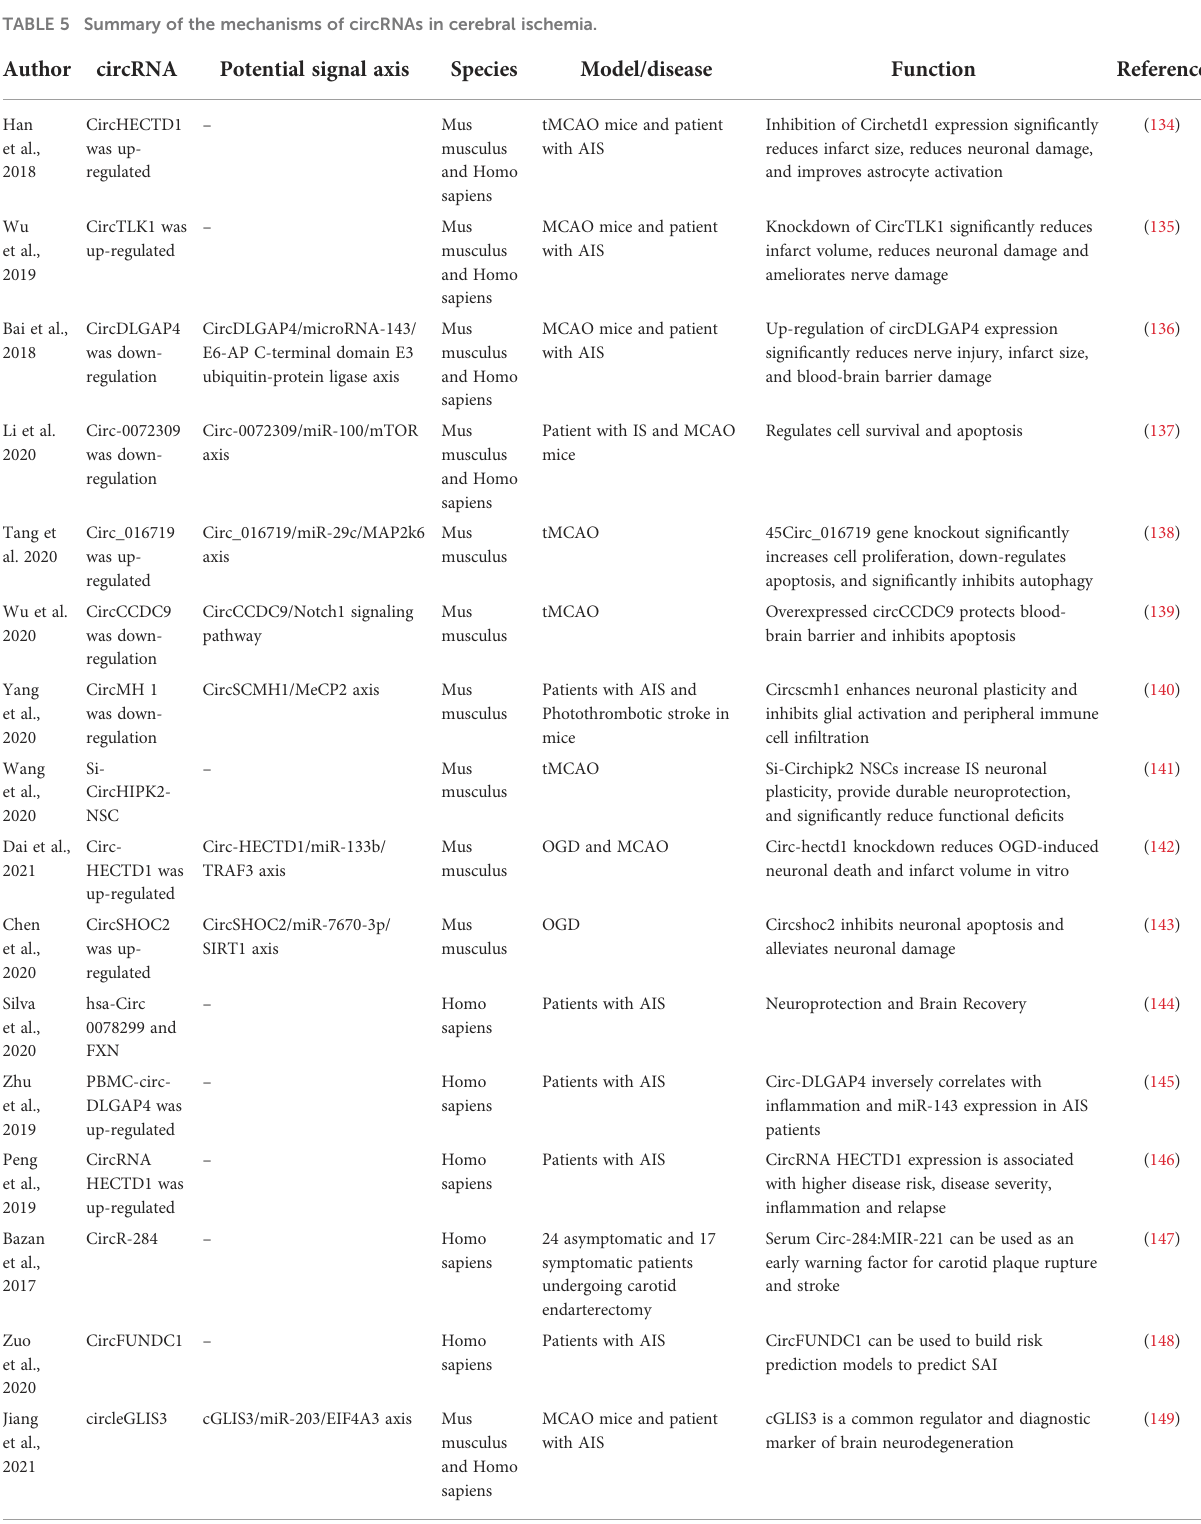
TABLE 5 Summary of the mechanisms of circRNAs in cerebral